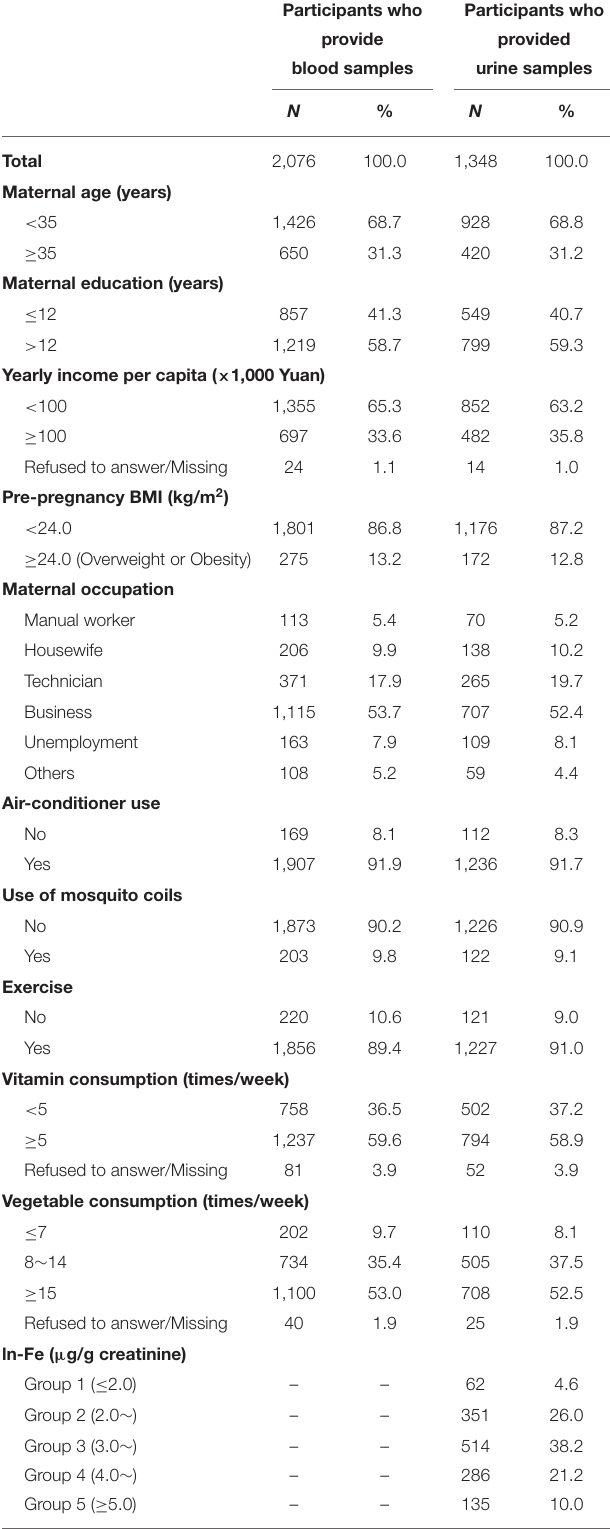
TABLE 1 | General characteristics of study participants. Table 1 describes the general characteristics of all